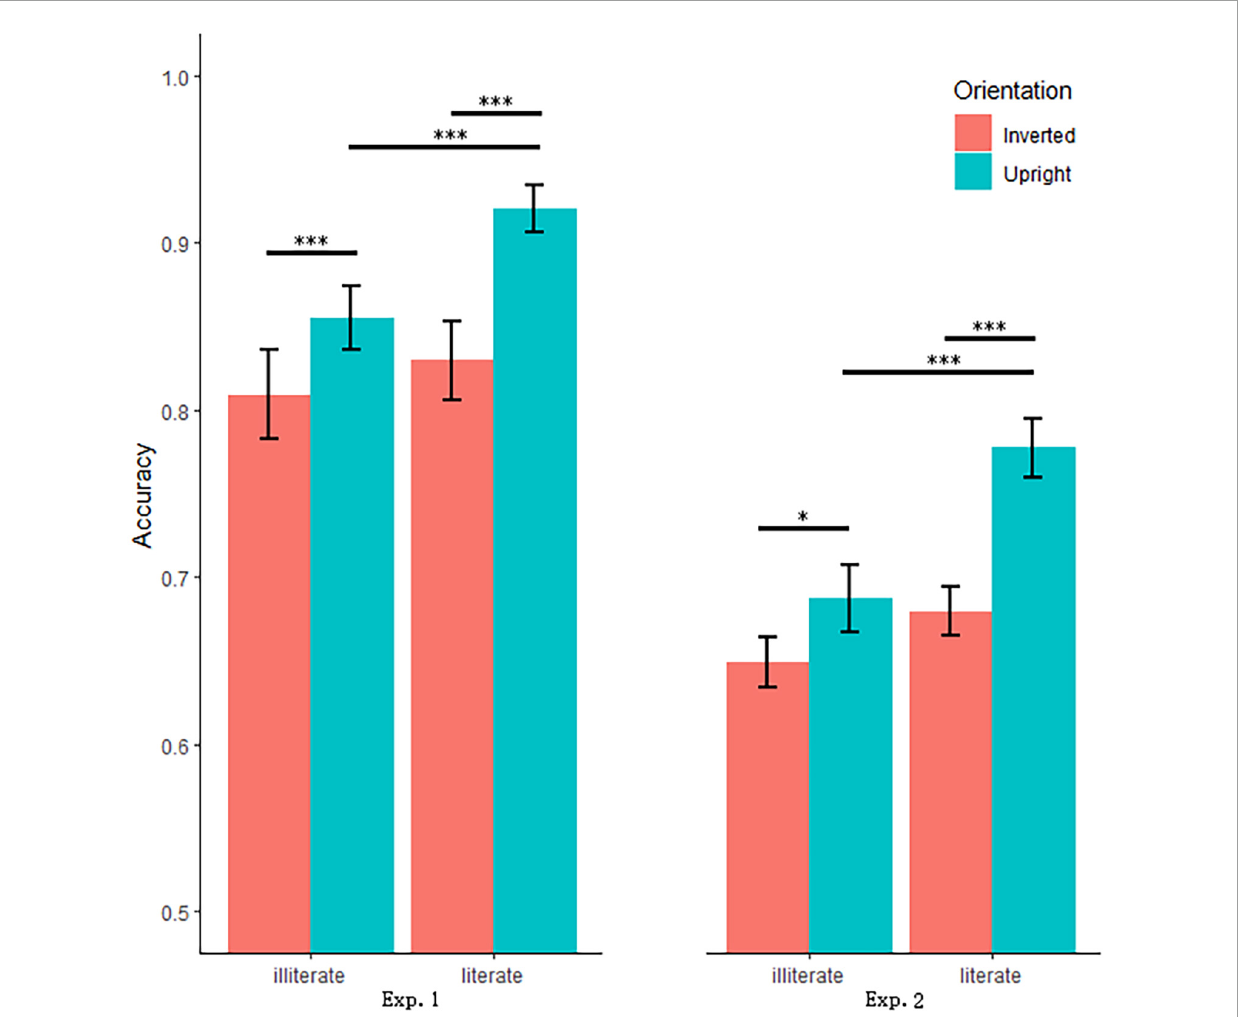
FIGURE3 Bar plot with mean accuracy and standard errors as a function of Literacy and Orientation in experiment 1 (left) panel and in experiment 2 (right) panel. Error bars indicated standard errors. ∗ Indicates p < 0.05, and ∗∗∗ indicates p <